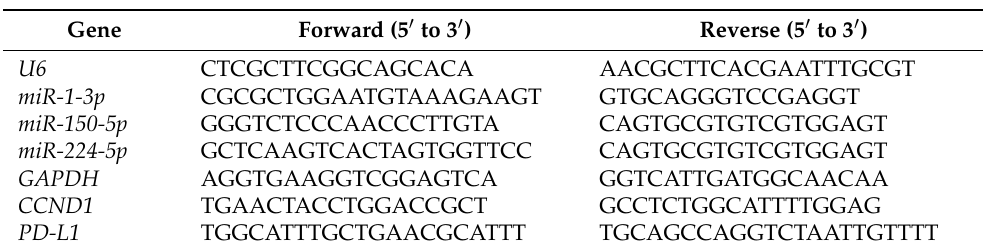
Table 2. RT-qPCR